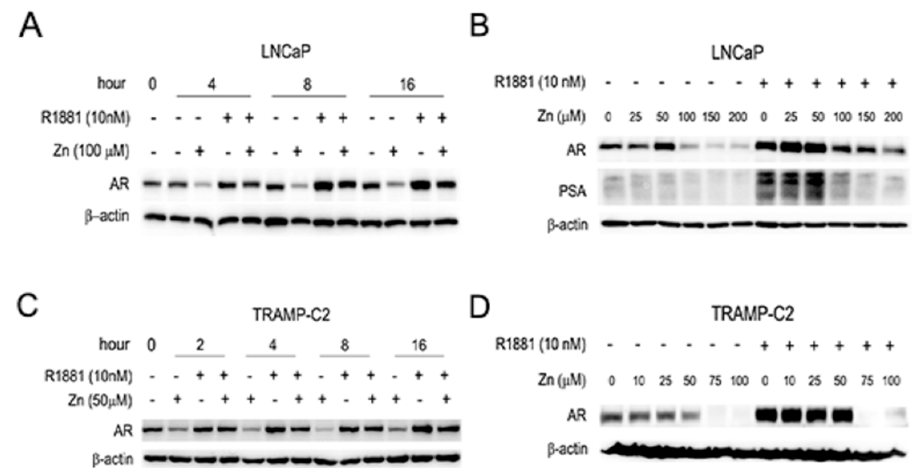
Figure 2. Zinc reduces AR and PSA protein expression. Western blot analysis showed the inhibitory activity of zinc on the expression of AR and PSA in human LNCaP ( A , C ) and mouse TRAMP C2 ( B , D ) PCa cells. LNCaP and TRAMP-C2 cells were grown in androgen-deprived conditions in the absence or presence of R1881.